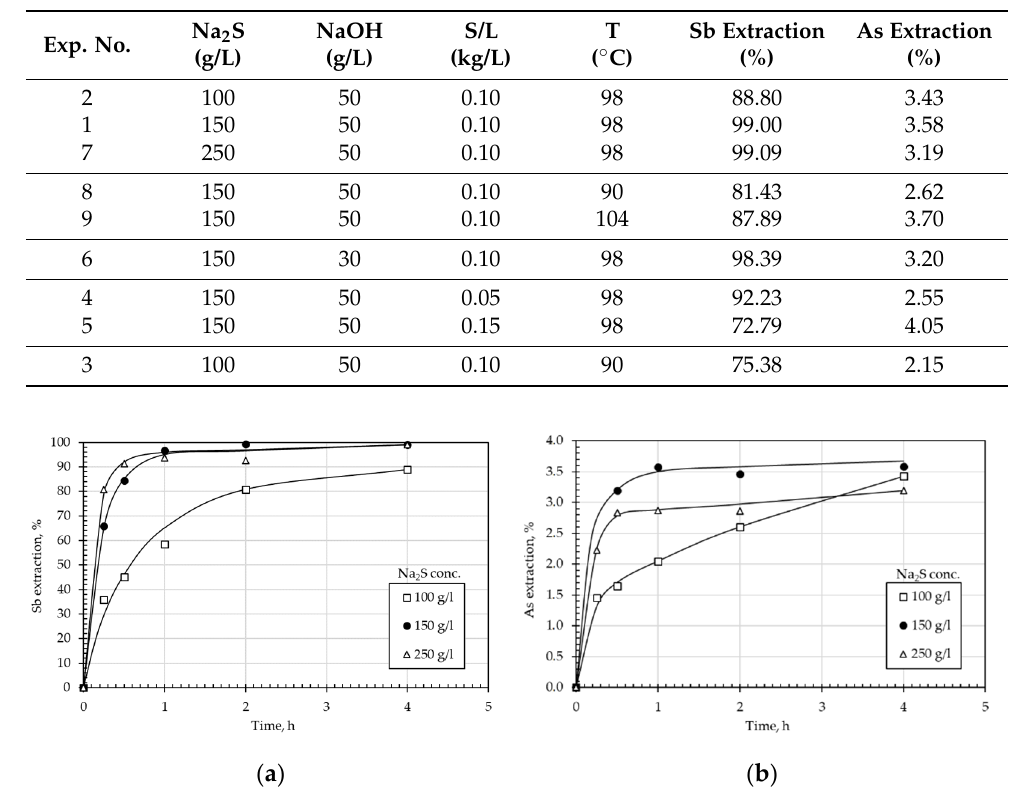
Table 2. Experimental conditions and Sb and As extraction (leaching time 4 h).